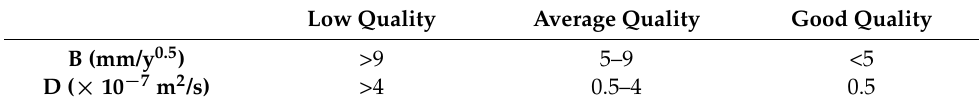
Table 1. Usual values of B and D [27].